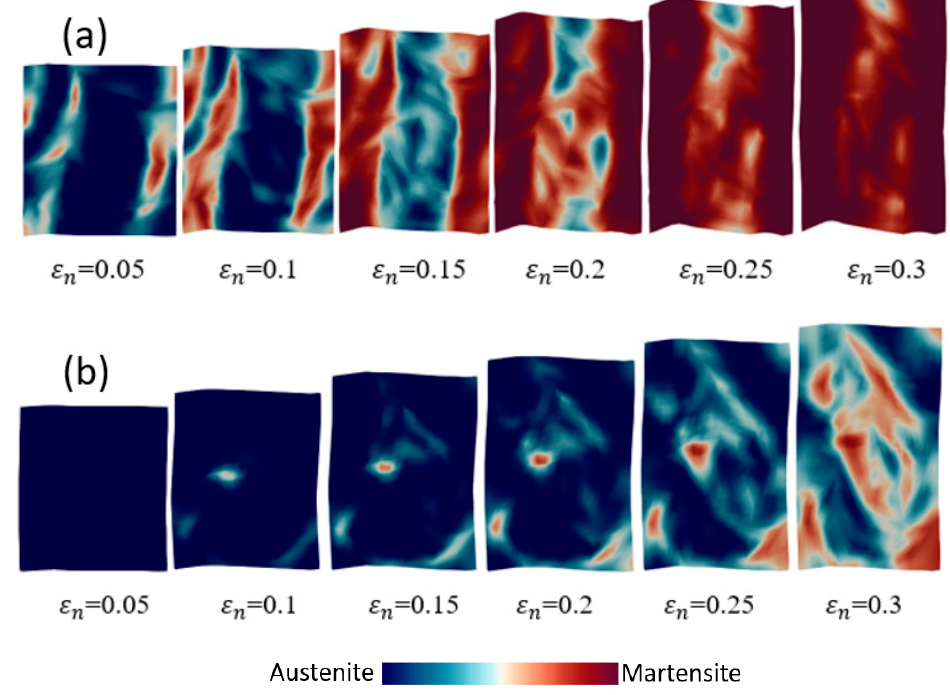
Figure 15. The distribution of martensitic phase of 14-grain polycrystal TRIP steel with a preferred orientation of ( a ) ∅ = 30 ° and ( b ) ∅ = 60 ° .